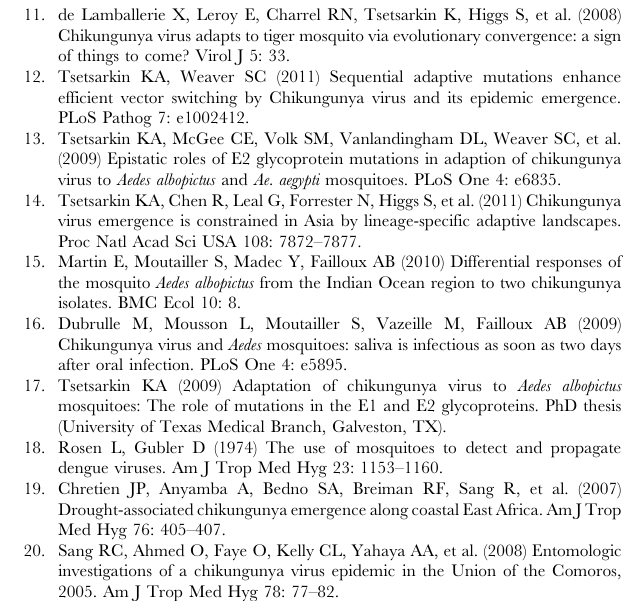
Figure S2 Growth curves of CHIKV, E1-226A and E1- 226V, in three cell lines. (A) Ae. aegypti Aag-2 cells, (B) Ae. albopictus C6/36 cells and (C) Green monkey Vero cells were infected with E1-226A (black) and E1-226V (grey) at a MOI of 0.1. After adsorption, the inoculum was removed and cells were washed. Then, medium with 2% FBS was added and cells were incubated at 28 u C for mosquito cells and 37 u C with 5% CO 2 for mammalian cells. Supernatants were collected at 2, 4, 6, 8, 10, 24 and 72 hours post-infection (pi). The number of CHIKV genomes was determined by quantitative RT-PCR and the number of infectious viral particles by plaque titration of the same